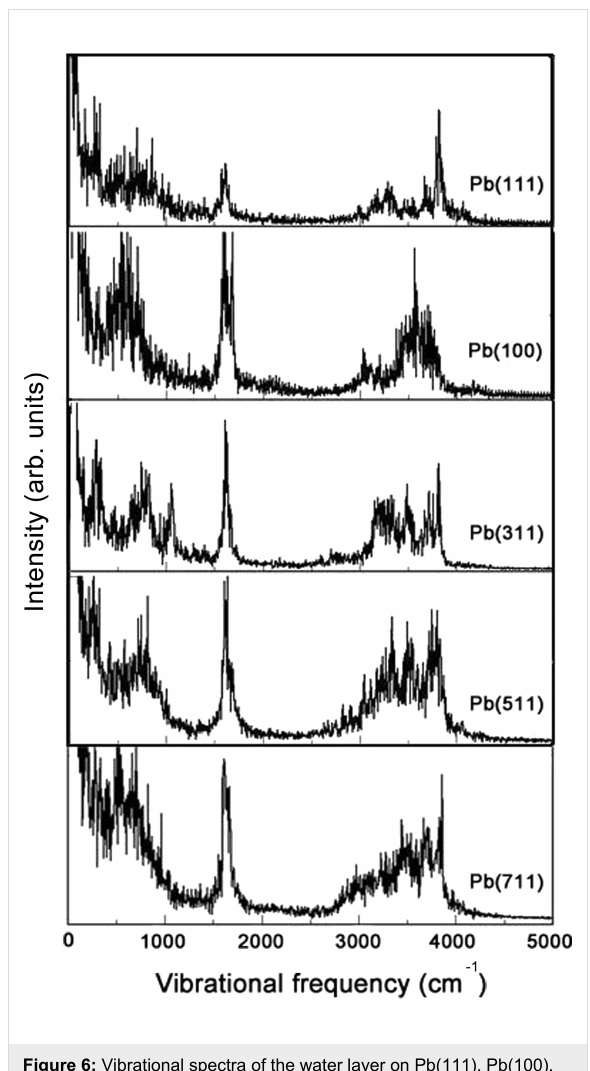
Figure 6: Vibrational spectra of the water layer on Pb(111), Pb(100), Pb(311), Pb(511) and Pb(711) derived from the Fourier transform of the velocity auto-correlation